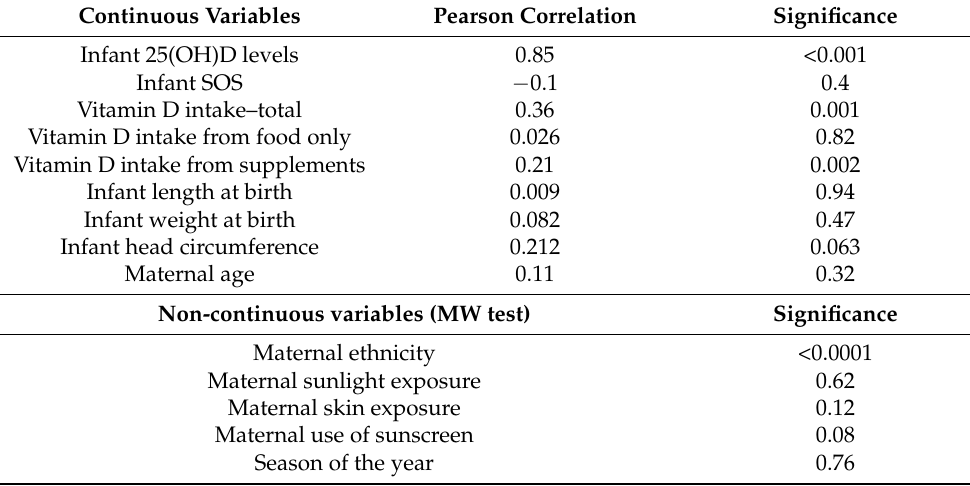
Table 3. Correlation between maternal 25(OH)D and maternal and infant variables. Continuous